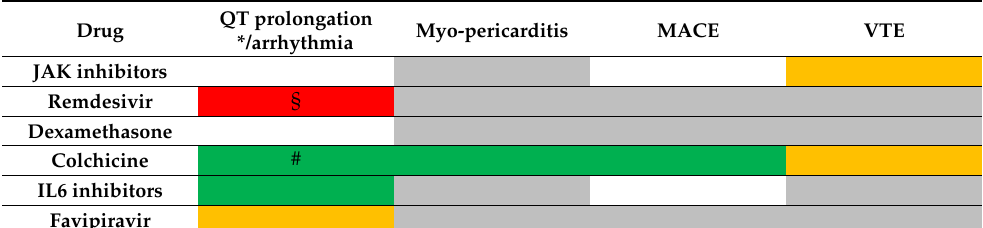
Table 5. Cardiovascular profile of t drugs used for the management of COVID-19. Only drugs with “most beneficial” effect on mortality or mechanical ventilation, duration of ventilation, length of hospital stay, or time to resolution of symptoms (as compared to the standard of care) were selected based on the updated living systematic review [1], last access 4 June